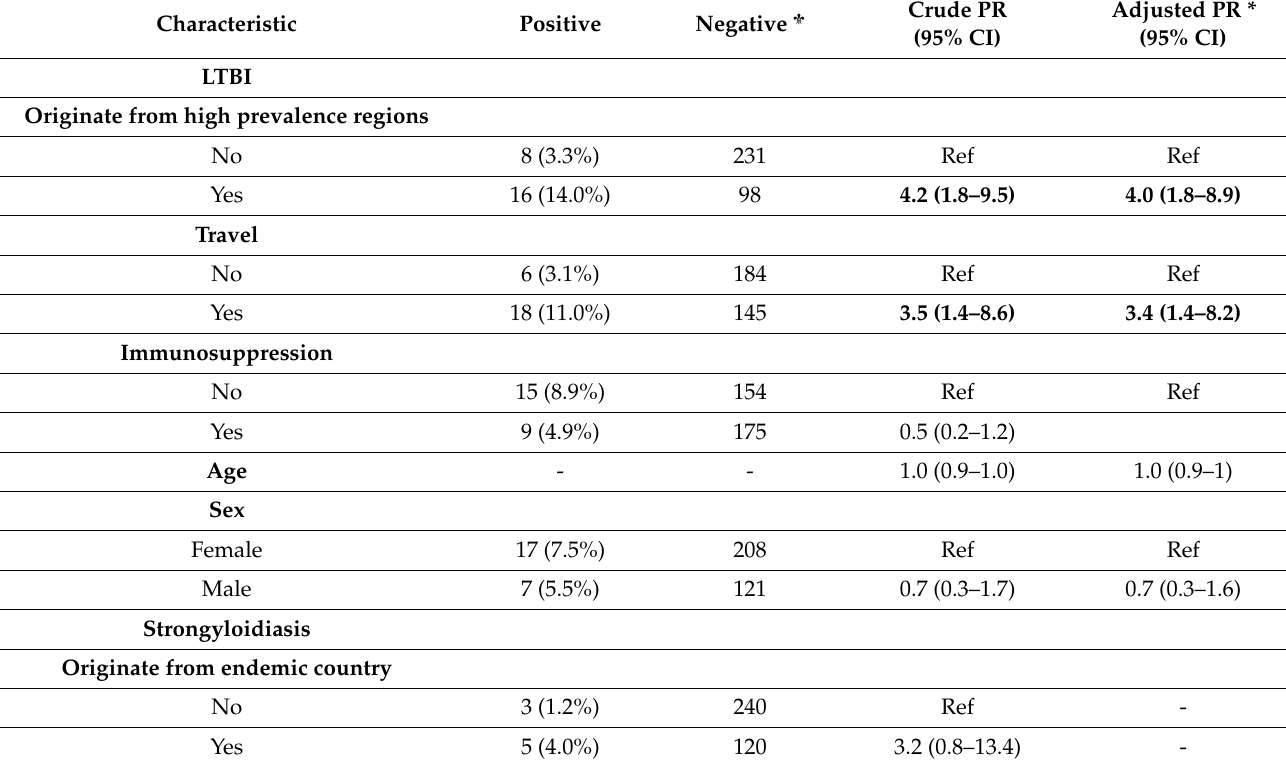
Table 4. Risk factors for latent tuberculosis infection (LTBI) and Strongyloidiasis.